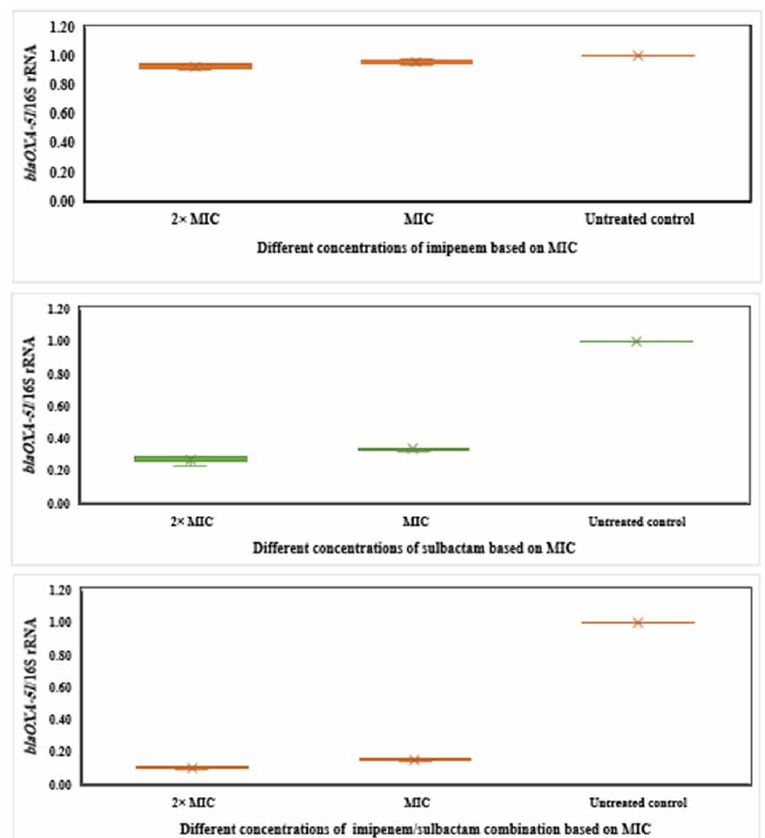
FIGURE 1 – Box plots of blaOXA-51/ 16S r RNA ratio at different concentrations of imipenem and sulbactam alone and in combination based on MIC in carbapenemases producing A. baumannii